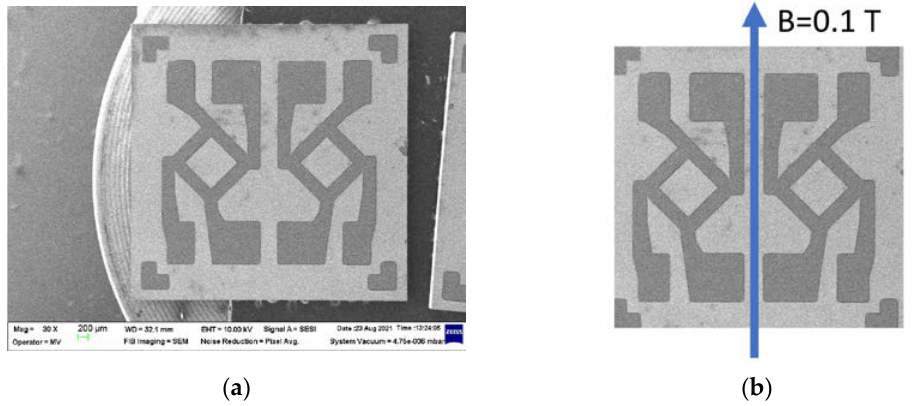
Figure 9. ( a ) SEM image of the AMR bridge sensor; ( b ) Direction and intensity of the applied field, B over the structure during the magnetic annealing process.